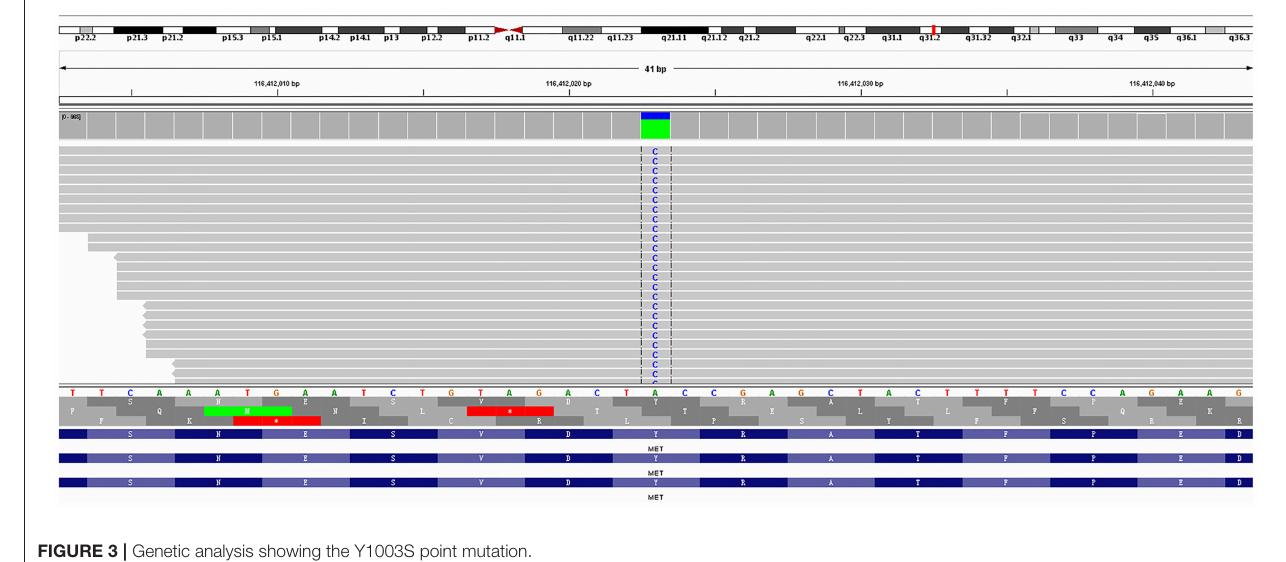
FIGURE 3 | Genetic analysis showing the Y1003S point mutation.